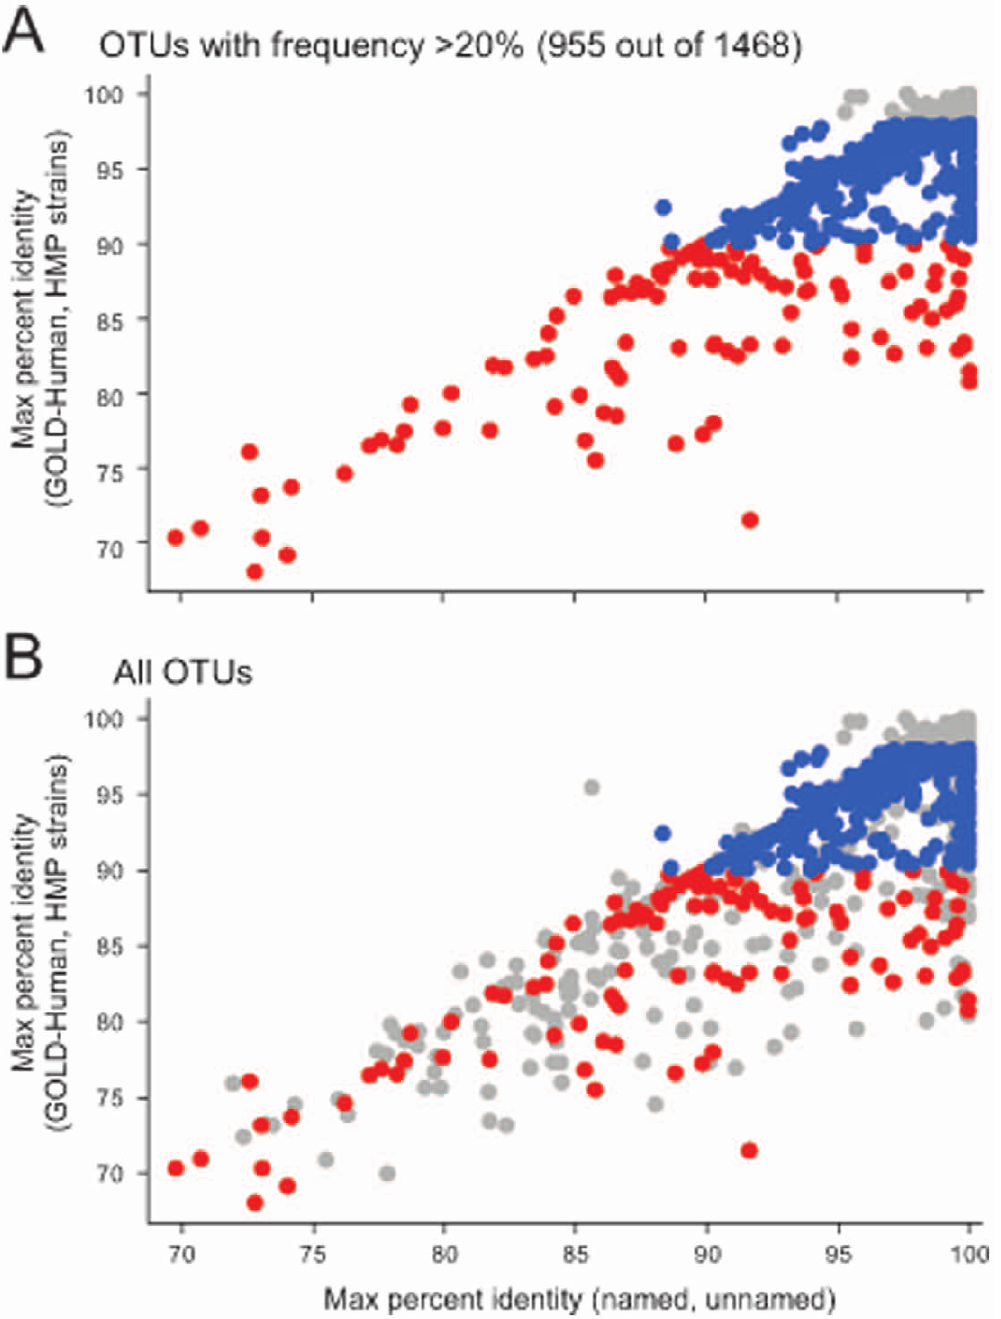
Figure 5. Nearly all sequenced taxa have been cultured but not all cultured taxa have been sequenced. For each taxa, the percent identity from the best match to a human sequenced database (GOLD-Human or HMP-strains) versus the best match to a sequence database of cultured organisms (named or unnamed). The colors in all panels indicate assignment to priority groups for whole genome sequencing: red=highest priority, blue=medium priority, gray=low priority. (A) OTUs that are present in at least 20% of all samples in at least one body habitat; (B) all HMP OTUs.